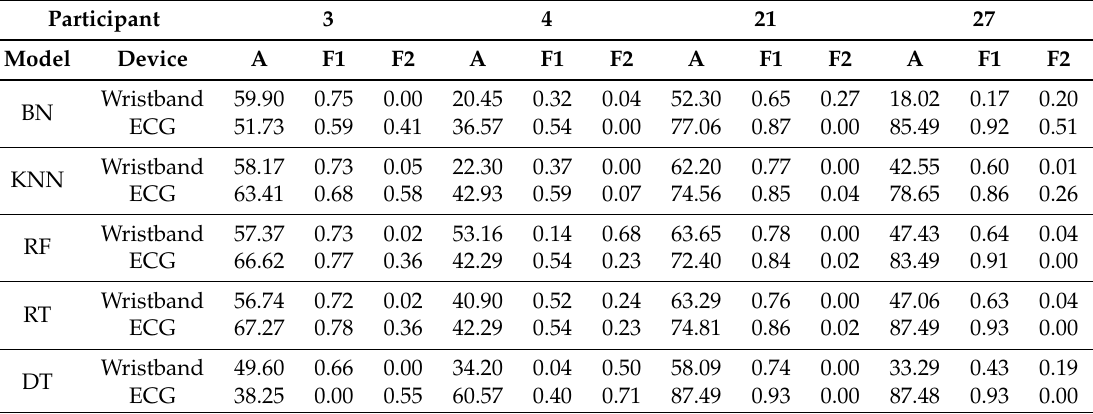
Table 7. Exemplary classification results of UIT for selected classifiers and subjects with performance measures for both wristband and